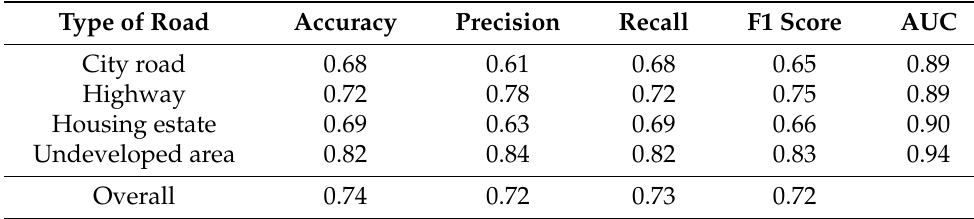
Figure A2. ROC curves of the SVM classifier. Table A1. Evaluation metrics of the SVM classifier on the test